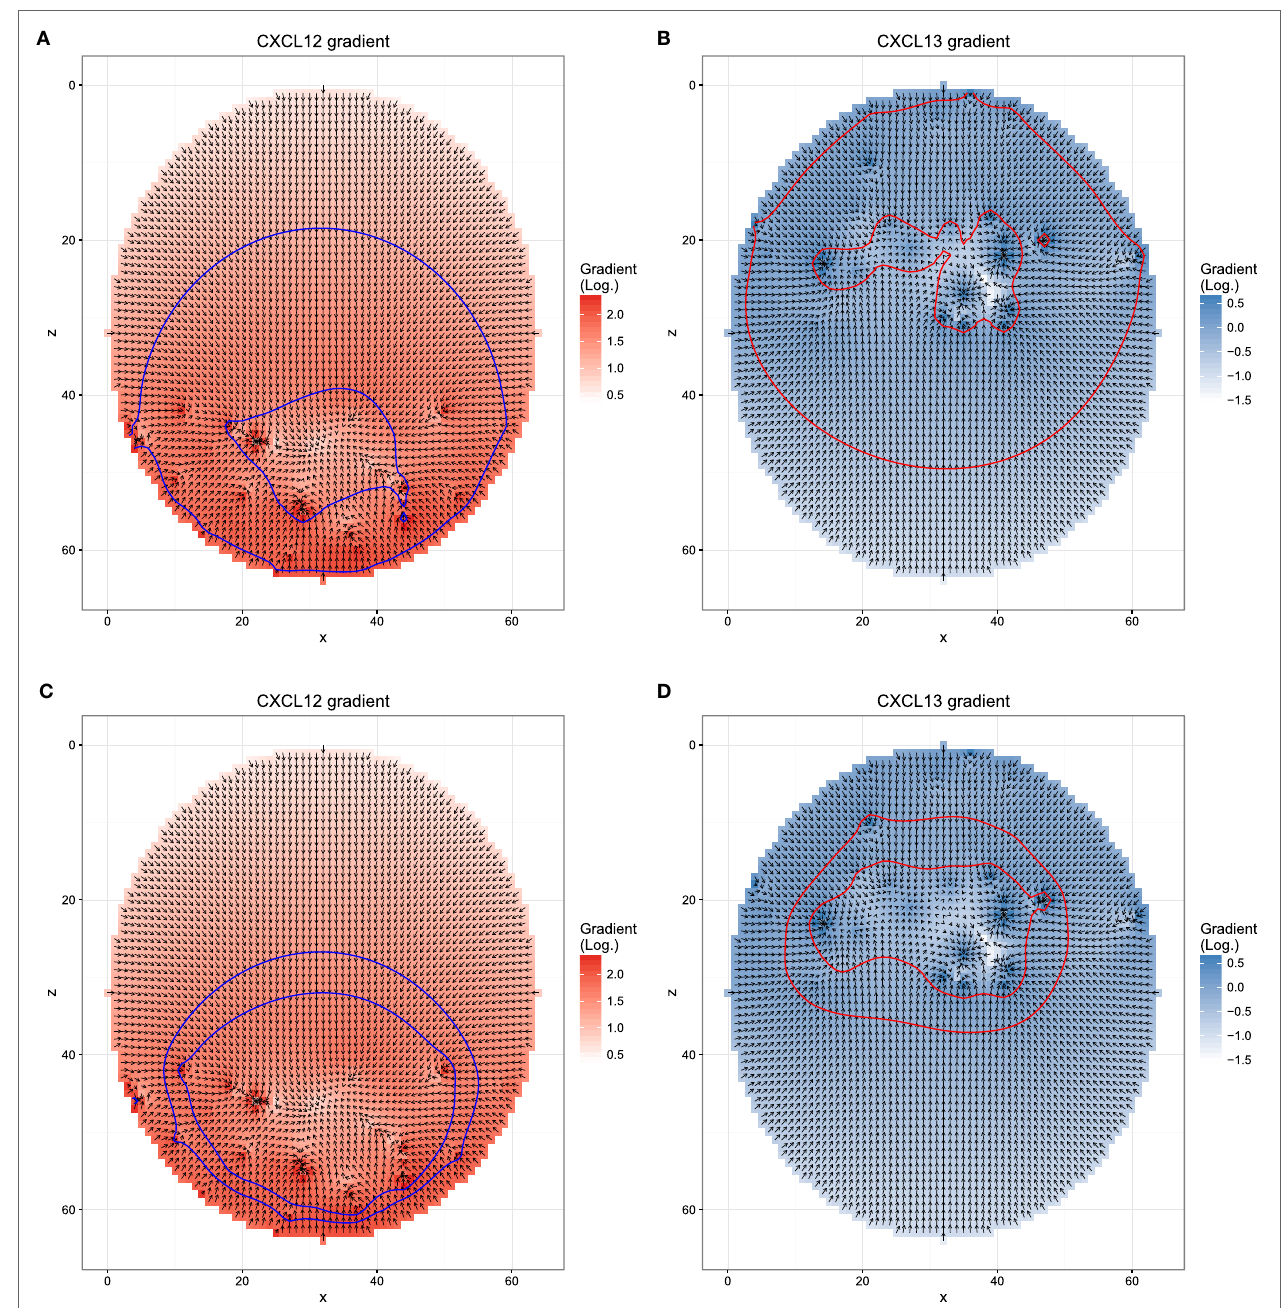
FigUre 5 | Different chemokine distributions that lead to reduced asymmetry in the transzone migration in silico . Figures show the chemokine gradient in a two-dimensional cutsection through a germinal center. Gradient directions are indicated by the arrows in the vector field plots, its magnitude is shown by the color. Lines indicate the positions at which desensitization (inner border) and resensitization (outer border) occur. (a,B) Chemotaxis with resensitizations at lower concentrations compared to the reference simulation; (c,D) chemotaxis with desensitization at the concentration at the zone boundary and resensitization at a 30% lower